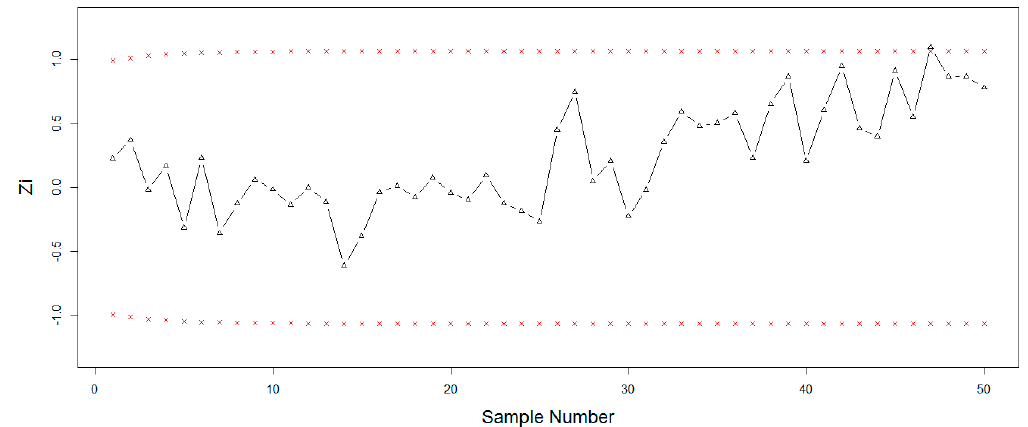
Figure 3. Graph of simulated data of the proposed EEWMA control chart when ψ 1 = 0.30, ψ 2 = 0.15, k = 2.956.